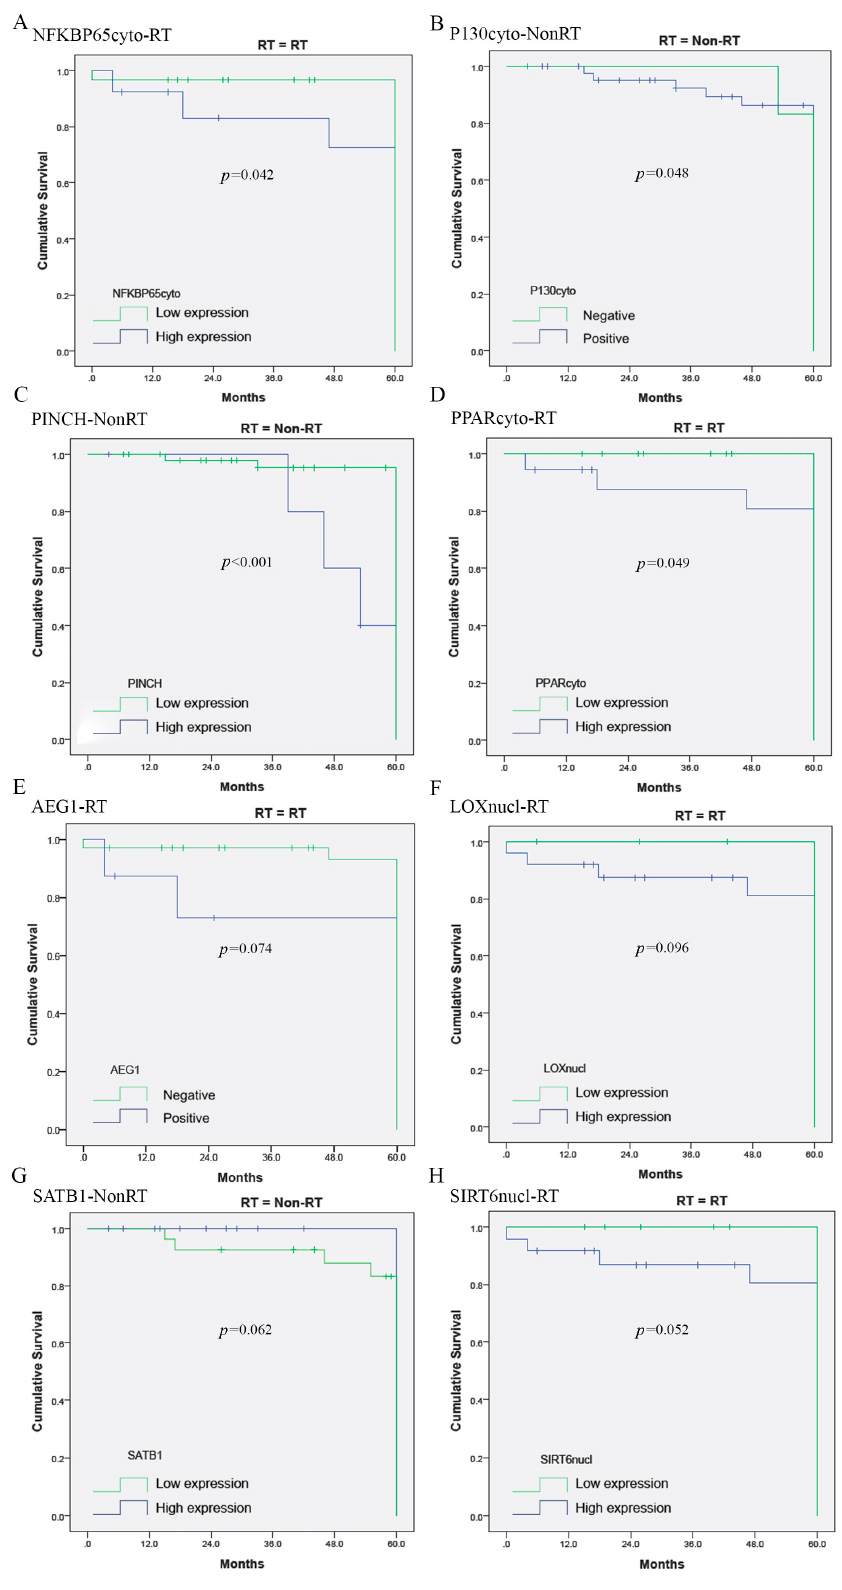
Figure 2. Survival analysis showed that four biomarkers in BS were significantly related to overall survival ( A – D ), while AEG1-RT (( E ), p = 0.074), LOXnucl-RT (( F ), p = 0.096), SATB1-NonRT (( G ), p = 0.062) and SIRT6nucl-RT (( H ), p = 0.052) tended to be related to overall